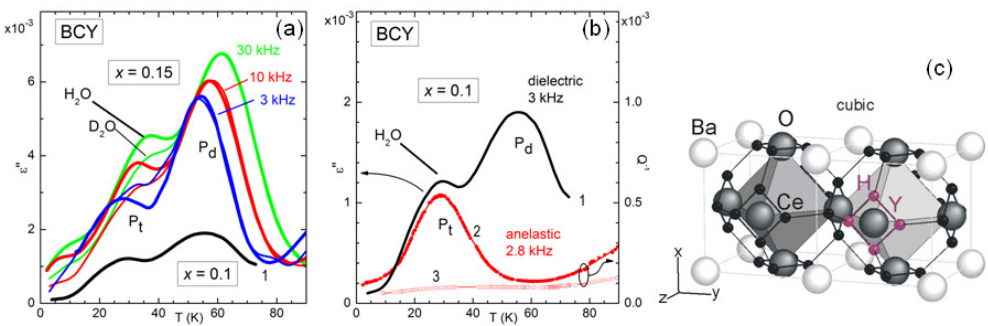
Figure 6. ( a ) Imaginary dielectric constant of hydrated BCY with x = 0.1,0.15 at LHe temperatures. When D is used instead of H, the dielectric loss presents a marked change in the position of the peak P t , which is also observed in the anelastic spectrum ( b ); and therefore is identified with H/D tunneling (data from Ref. [12]); ( b ) Imaginary dielectric constant (same curve 1 as in ( a )) and elastic energy loss Q − 1 (curve 2) of hydrated BCY with x = 0.1; curve 3 is the outgassed state; ( c ) Two cubic cells of BCY with the positions occupied by H/D as small black spheres. At LHe temperature H is confined and tunnels around an O atom neighbour to the acceptor impurity Y. Adapted with permission from Ref. [12], copyrighted by the American Physical